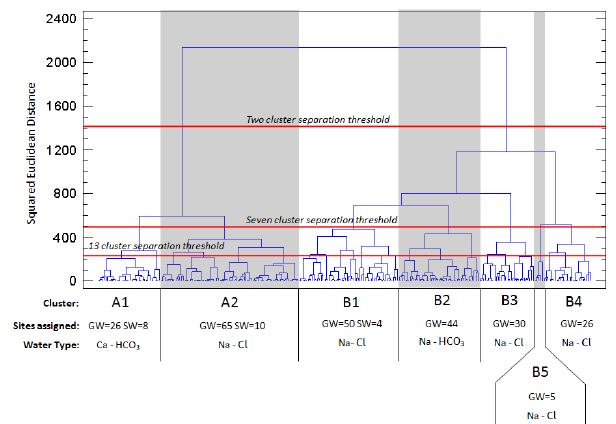
Fig. 4. Dendrogram for the 246 groundwater (GW) and 22 surface Figure 4. Dendrogram for the 246 groundwater (GW) and 22 surface water (SW) monitoring 3 water (SW) monitoring sites from the Wairarapa Valley classified sites from the Wairarapa Valley classified into seven clusters. Based on the format of Cloutier 4 into seven clusters. Based on the format of Cloutier et al. et al. (2008). 5 6